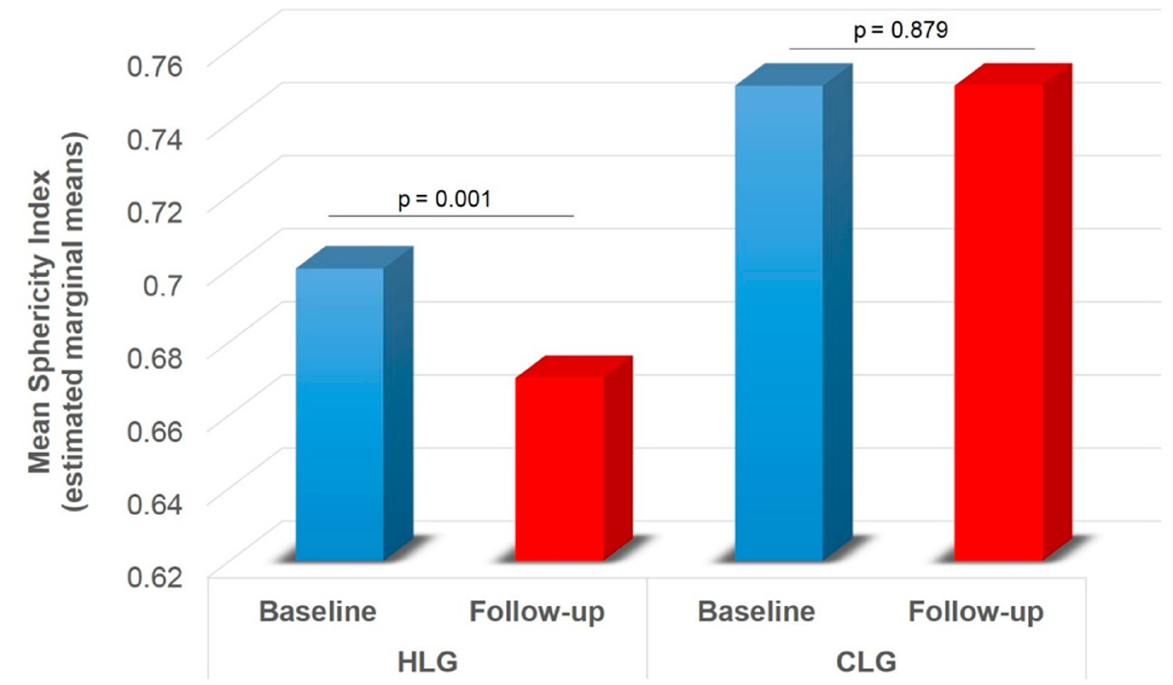
Figure 7. Ablation zone mean sphericity index across HLC and CLG for baseline and follow-up (significant group by time interaction effect). HLC = healthy liver group; CLG = cirrhotic liver group mean short axis 1 and short axis 2 diameters. Values are estimated marginal means following 2 × 2 mixed model ANOVA (group by time), controlling for gender (gender = 1.30). Bonferroni corrected p -values are presented for each comparison between baseline and follow-up within each group.